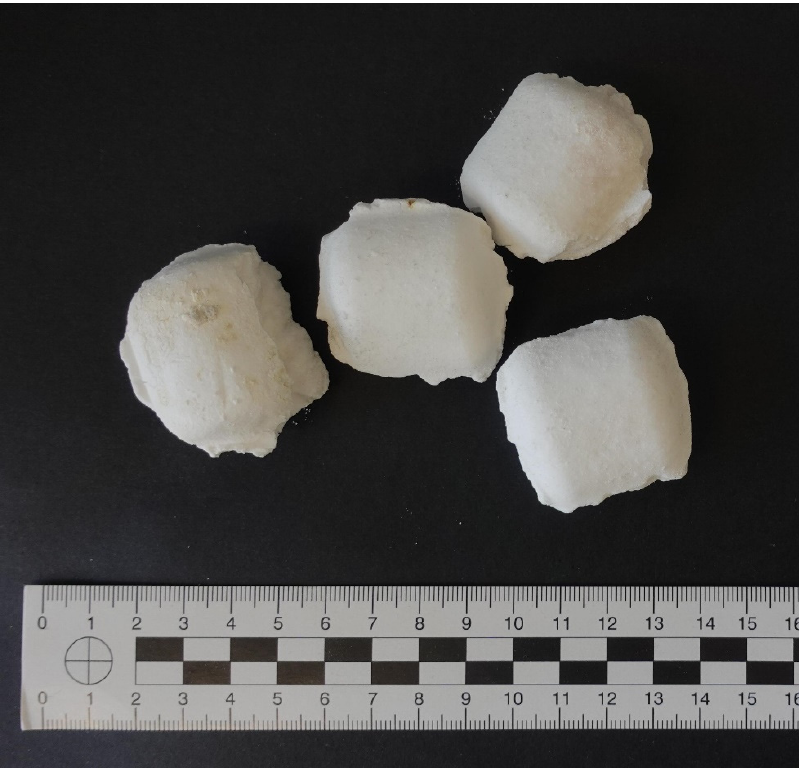
Figure 1. Substance discovered near cadaver, subjected to evaluation for cyanide in its composi-